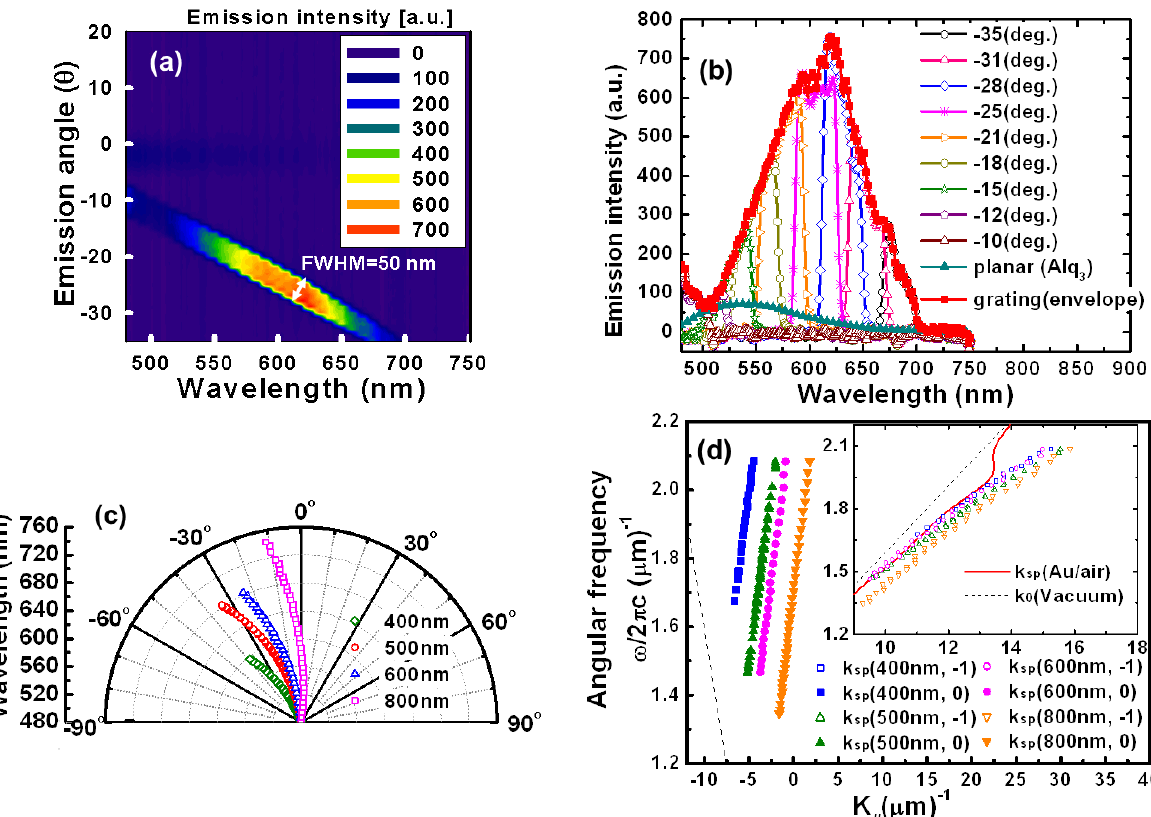
Figure 2. The PL emissions obtained for organic plasmon-emitting diodes (grating pitch, 500 nm; area, 1.2 × 1.2 mm). ( a ) A 3-D plot showing the PL spectra at different viewing angles of the device (grating pitch, 500 nm), ( b ) the PL of grating and non-grating (planar, Alq emission) samples as well as the integration of overall emission angles (envelope) and 3 ( c ) spectral peaks at different viewing angles for devices with different pitches. ( d ) Relation between angular frequency and wave vector (ω-k). Solid symbols show the experimental data (m = 0) obtained at different grating pitches. Open symbols (inset) are the calculated results corresponding to m = −1. Solid and dashed lines represent calculation results for the dispersion relation at the Au/air interface and for air, respectively. The fitting results approximate the theoretical dispersion relation. The data are given for a sample with 500 nm grating